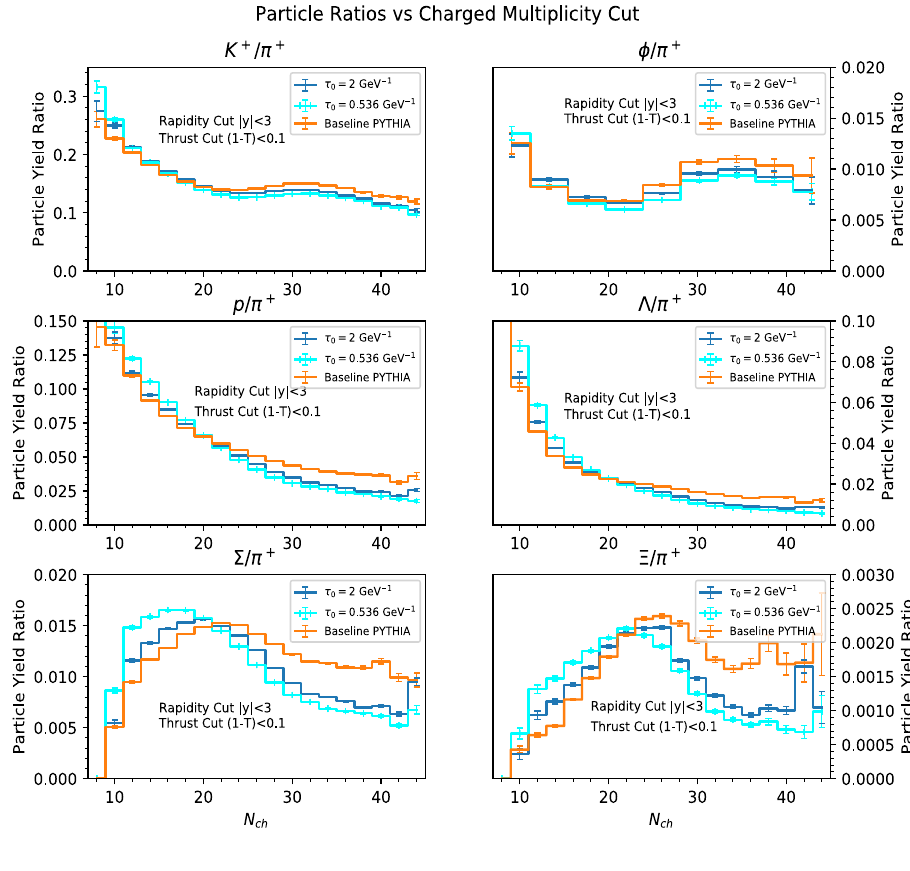
Fig. 9 Particle yields as a ratio to pions for K + , φ , p , (cid:14) , (cid:15) and (cid:16) after